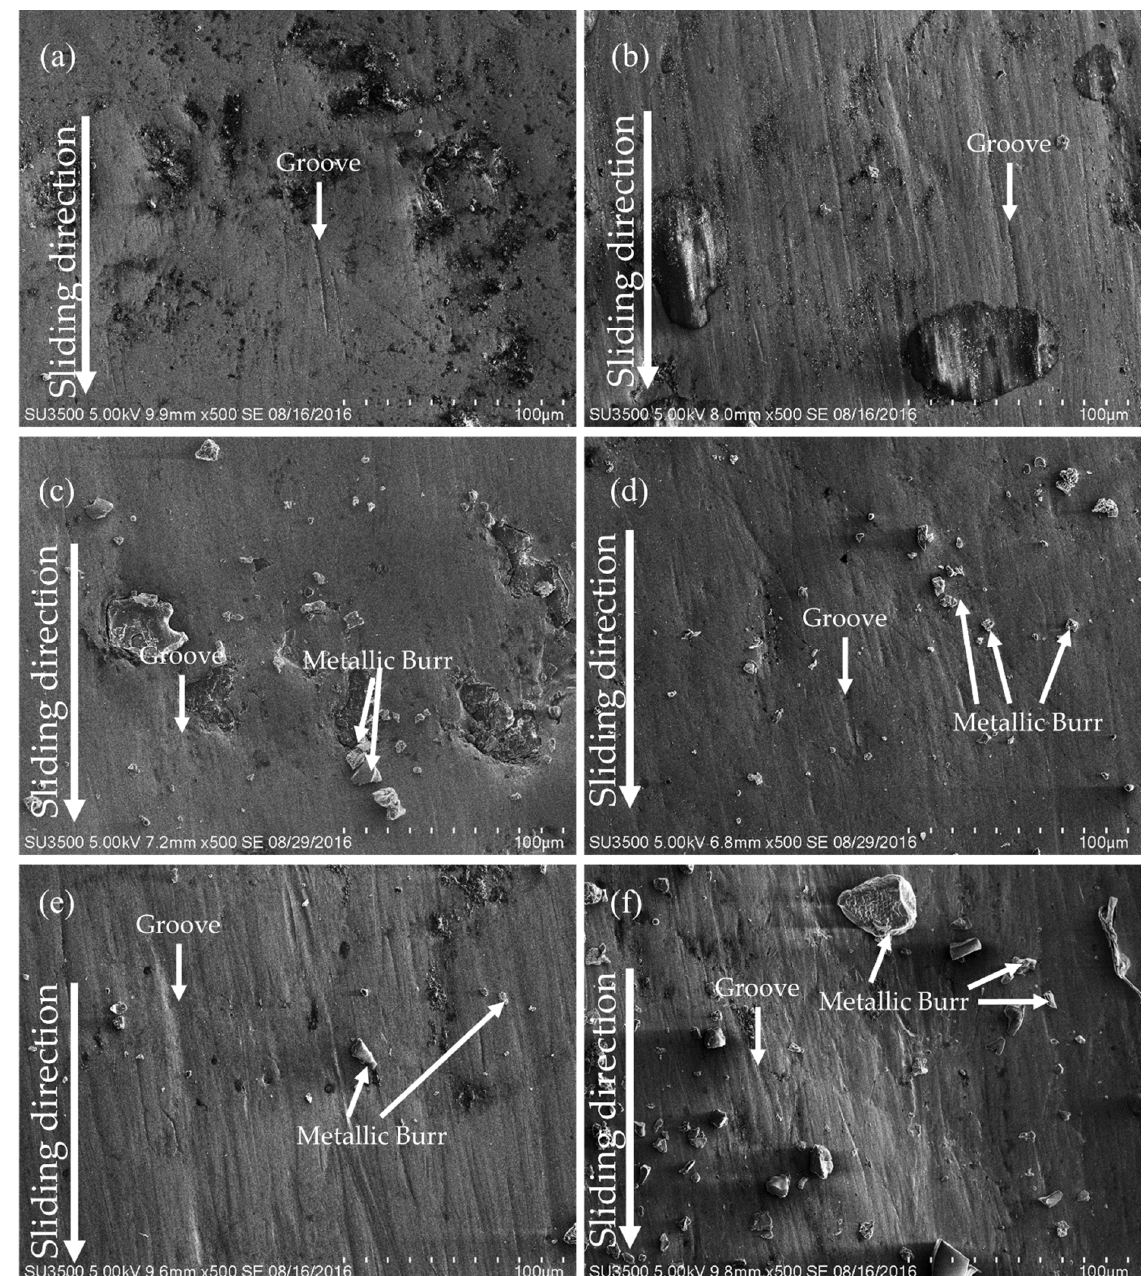
Figure 8. Micrographs of the worn-out surfaces after the ASTM G65 abrasion resistance test for hardfacing coatings sintered in an oven under six different atmospheres: ( a ) 10C, ( b ) 9C, ( c ) 7C, ( d ) 5C, ( e ) 3C and ( f ) 1C.